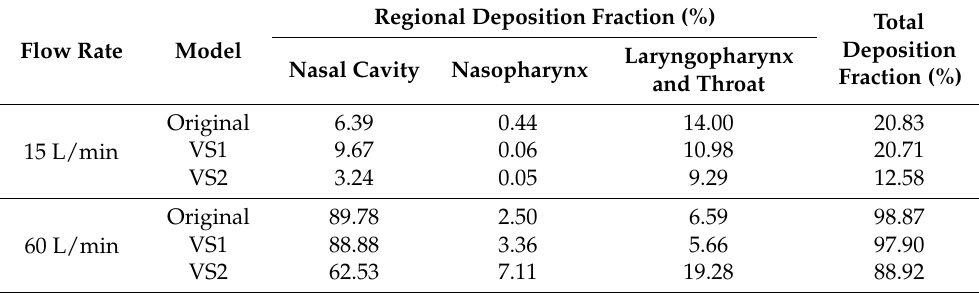
Table 2. Regional deposition fractions of 6 µ m particles in the nose-to-throat